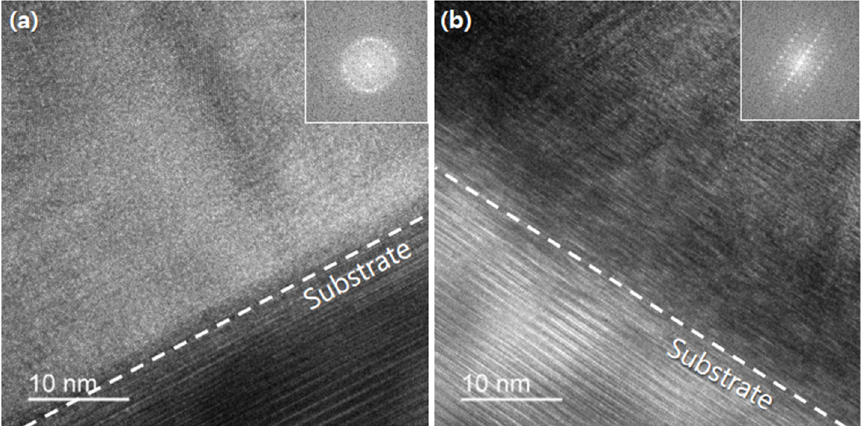
Figure 5. TEM cross-section and fast Fourier transform (FFT) images of SiC films deposited at (SiH 4 + CH 4 )/H 2 gas ratios of ( a ) 0.04 and ( b ) 0.01.